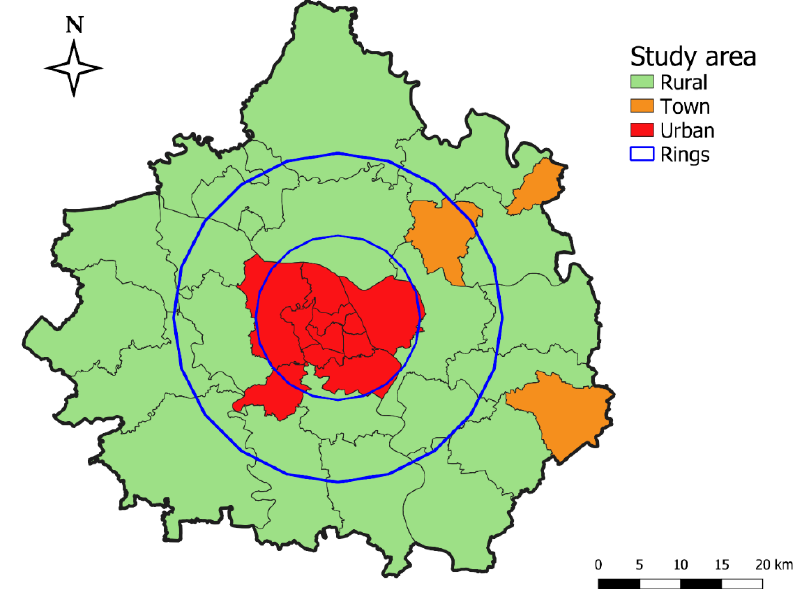
Figure 2. The classified districts of the study area (rural, town and urban), overlaid by two rings (10 and 20 km from the center, respectively), which identify the three concentric areas (core, first core and outside